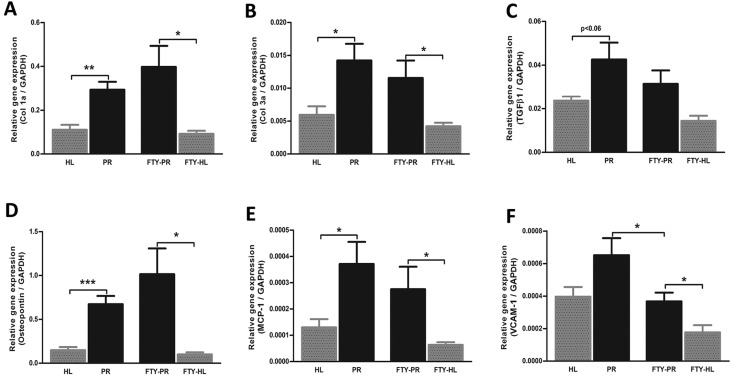
Effects of FTY720 treatment on mRNA expression of fibrotic and inflammatory markers. Quantitative RT-PCR data showed that the mRNA expression of fibrotic and inflammatory markers, which have been increased significantly upon proteinuria (A-F), was not reduced by FTY720 treatment (A-E), except for significant prevention of VCAM-1 mRNA increase (F). HL, healthy; PR, proteinuric untreated; FTY, FTY720. *P<0.05, **P<0.01, ***P<0.001.